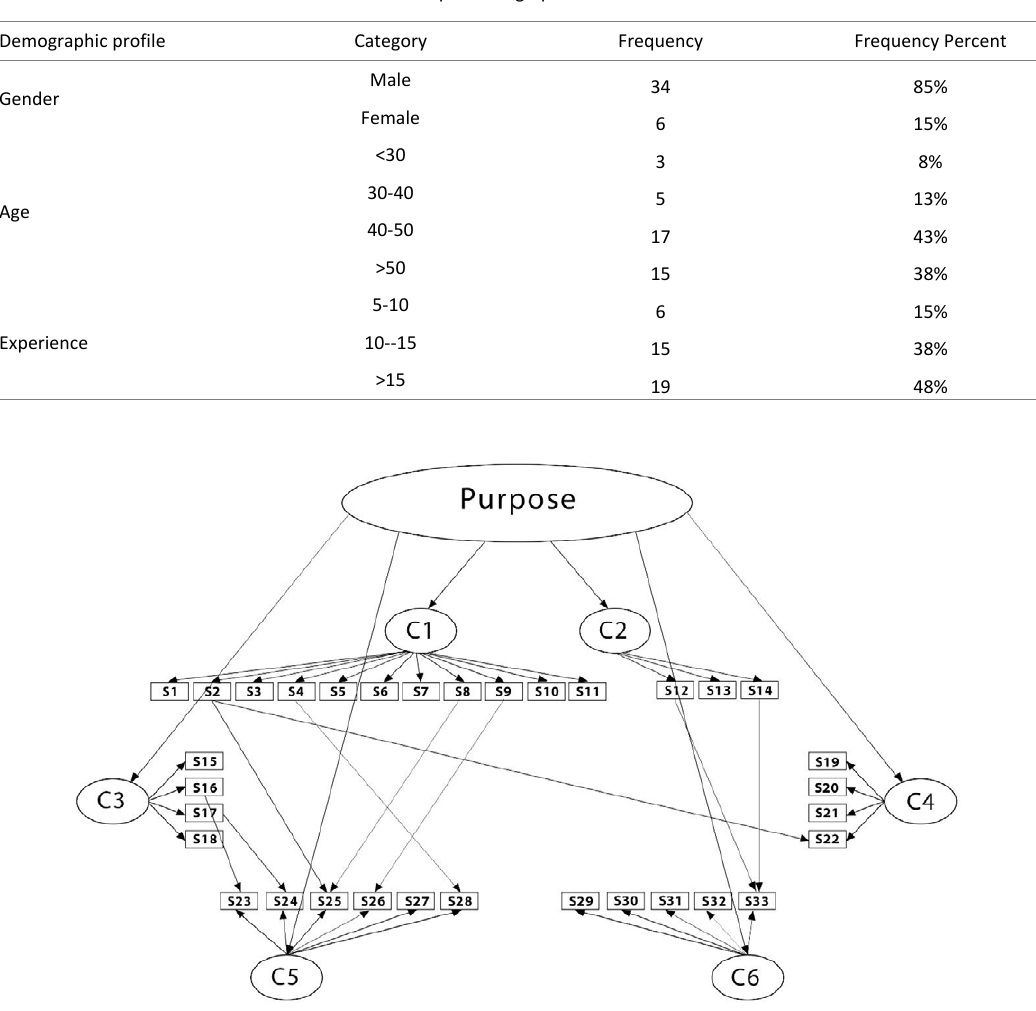
Table 3. After data gathering, the data analysis was done using SuperDecision software. To implement the ANP analysis, the main criteria, the sub-criteria of each criterion, the sub-criteria that are intrinsically linked effect of each criterion must be compared together.